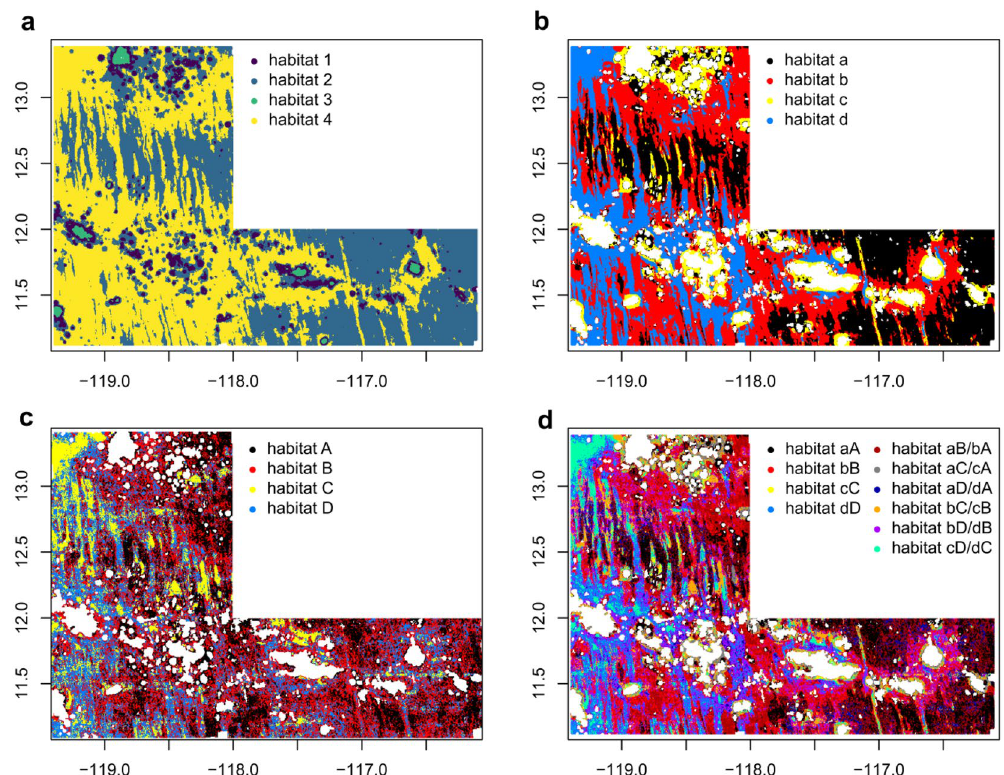
Figure 4. Habitat maps of the German contract area computed with k-means clustering for megafauna morphotypes, bathymetric variables and backscatter value, sediment and nodule parameters ( a ), only including megafauna morphotypes, bathymetric variables and backscatter value and excluding seamount sites ( b ), for meiofauna abundance, bathymetric variables and backscatter value as computed by Uhlenkott et al. 22 with k-means clustering ( c ) and differences between the habitat maps computed for meiofauna and megafauna excluding seamount sites ( d ). Habitat map for meiofauna obtained from https:// doi. org/ 10. 1594/ PANGA EA. 912217 32